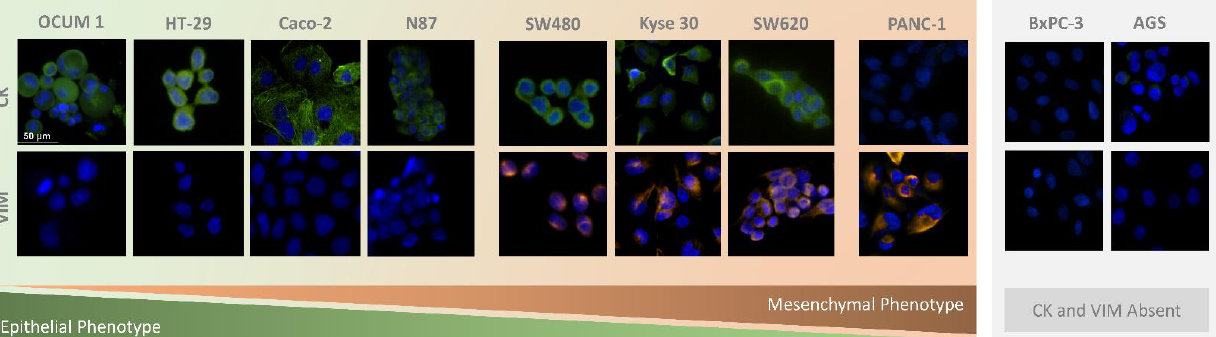
Figure 7. Microscopic images obtained from immunocytochemistry assays in adherent colorectal (SW480, SW620, Caco-2, HT-29), pancreatic (PANC-1, BxPC-3), gastric (N87, OCUM 1, AGS), and esophageal (Kyse 30) cells.